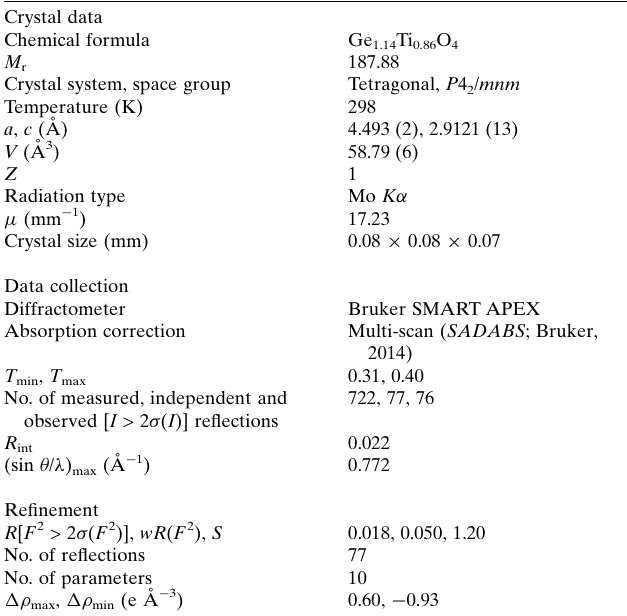
Table 2 Experimental details. Crystal data Chemical